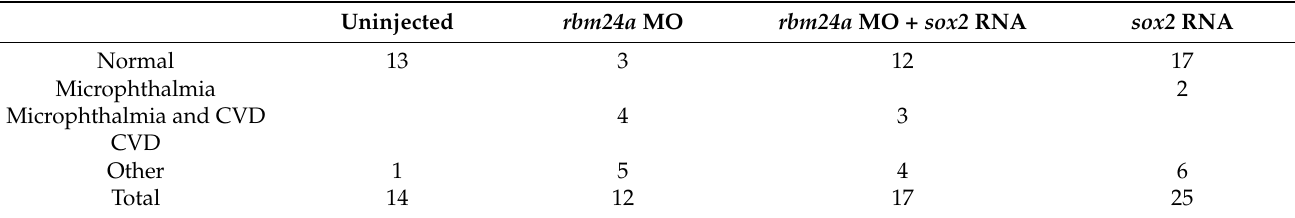
Table 4. Number of phenotypes associated with uninjected, rbm24a knockdown, rbm24a knockdown with sox2 RNA, and sox2 RNA